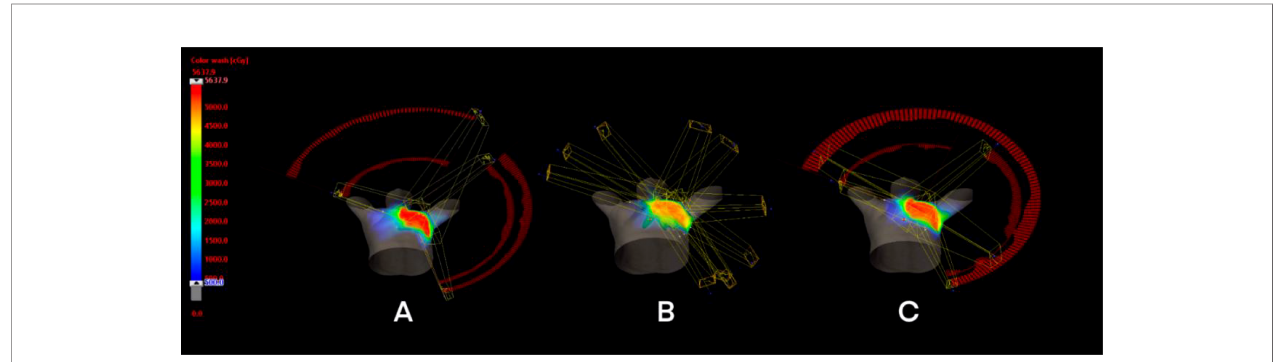
FIGURE 1 | Treatment planning design for three techniques: (A) T-VMAT; (B) IMRT; (C) H-VMAT.